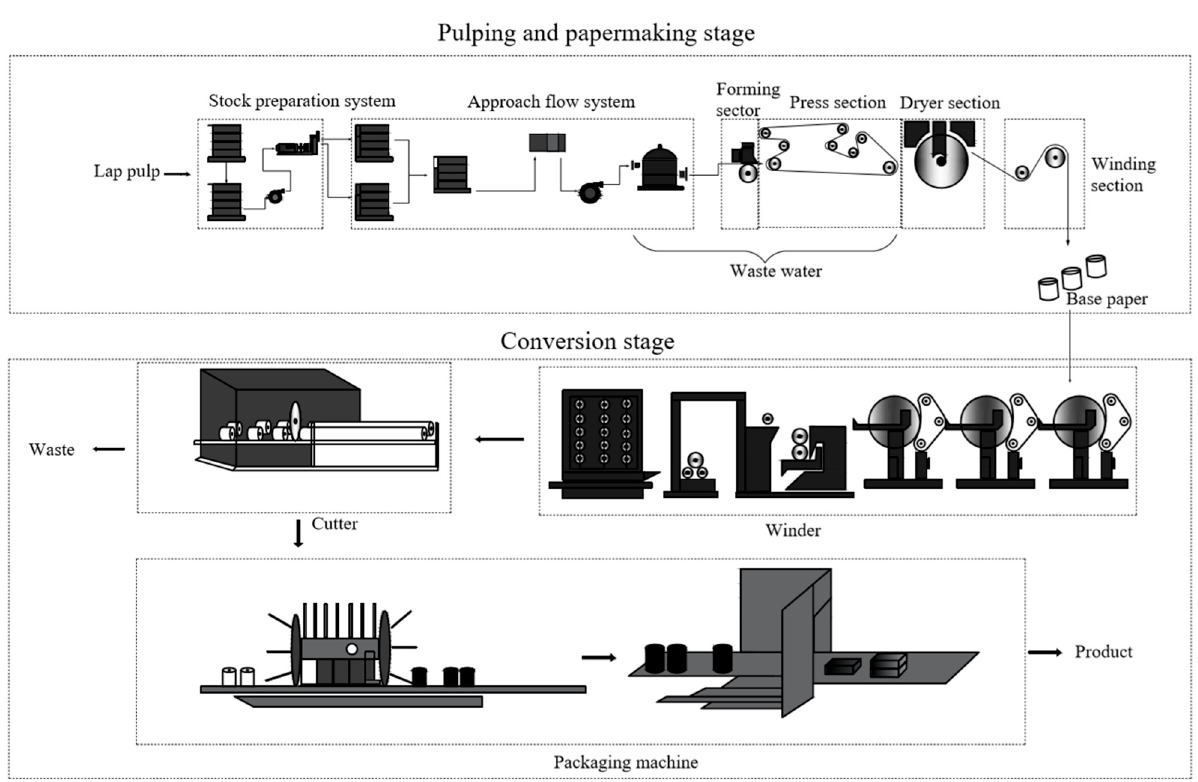
Figure 1. Production process of tissue paper mills.